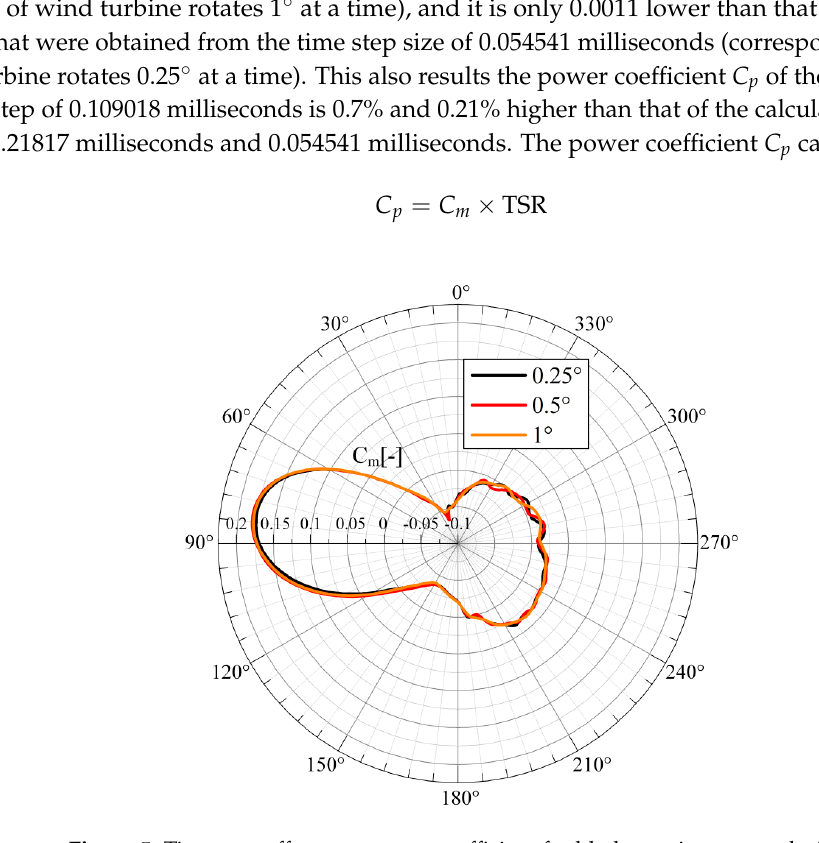
Figure 5. Time step effects on torque coefficient for blade one in one revolution.